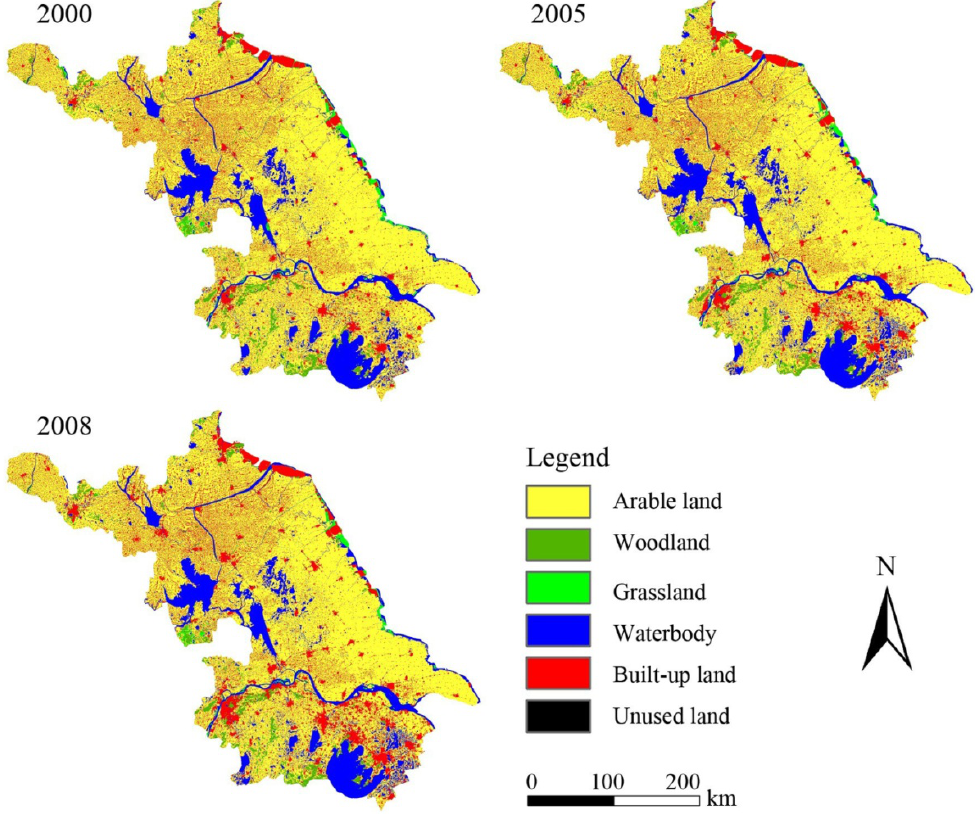
Figure 2. Land use map of Jiangsu Province during 2000, 2005 and